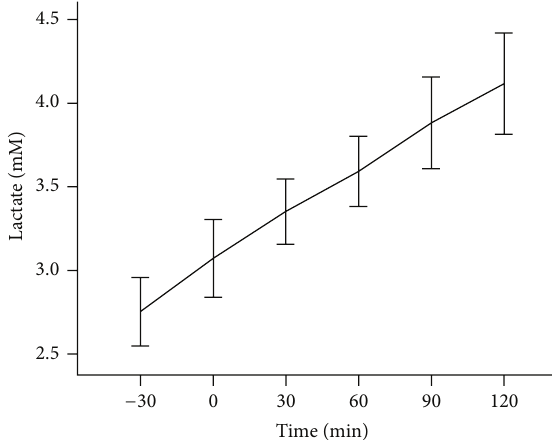
Figure 2: Lactate levels during HIEC. Plasma lactate was measured as shown in Study Subjects. The figure shows lactate levels increase over